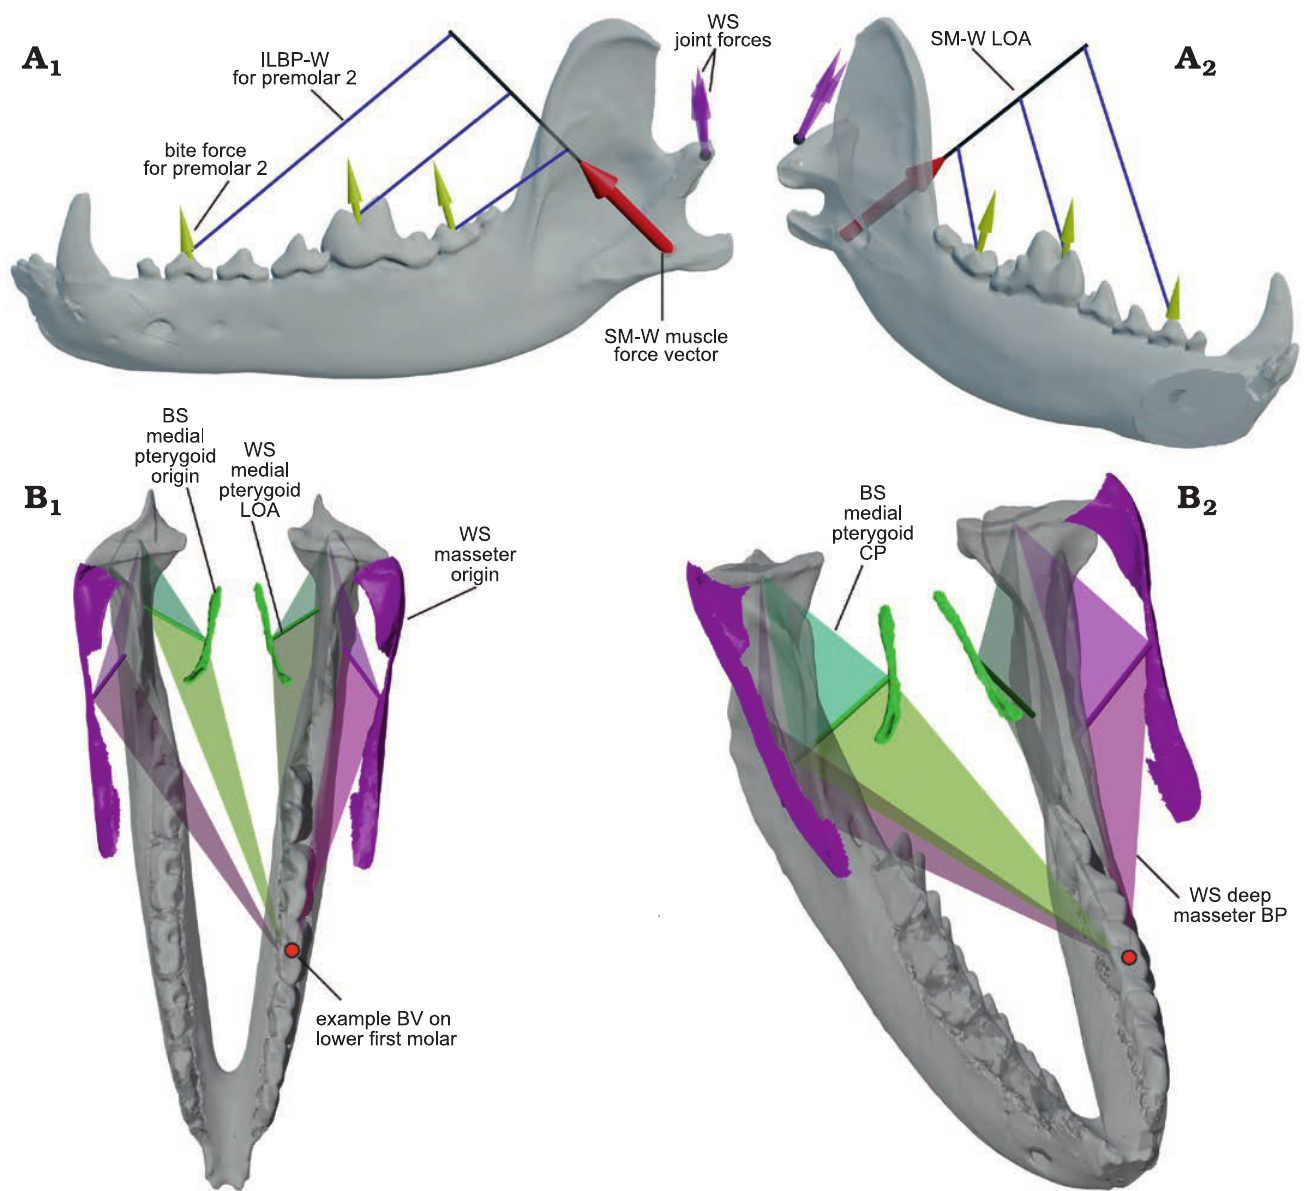
Fig. 4. Example 3D renderings of the bifulcral mandibular leverage parameters used in this analysis. A . Example of bifulcral lever arms corresponding to the working-side superficial masseter (SM-W) shown in a semi-transparent hemimandible of Canis familiaris Linnaeus, 1758; the muscular resultant vector is shown as a red arrow, with corresponding bite force vectors (yellow arrows) and working-side joint force vectors (purple arrows) shown for three positions on the lower postcanine tooth row. As can be seen, the in-lever lengths around the bite point fulcra (used in the calculation of joint force) increase significantly mesially. In labial (A 1 ) and oblique (A 2 ) views. B . Example of the varying condylar planes (CP) and bite planes (BP) used in the 3D bifulcral analysis, shown in Diceros bicornis (Linnaeus, 1758) for a bite point on the lower first molar. The mandible is shown in semi-transparent gray, while the working- and balancing-side origin surfaces for the deep masseter muscles on the skull are shown bilaterally in solid pink; similarly, the isolated origin surfaces of the medial pterygoids are shown in solid green. The muscular lines of action (LOA) for these four muscles are also shown as solid tubes, while transparent triangles demonstrate the orientations of the CP and BP for the corresponding muscle. In superior (B 1 ) and oblique (B 2 ) views. Not to scale. Abbreviations: BS, balancing-side; BV, bite vertex; ILBP-W, in-lever of the bite plane on the working-side; SM-W, superficial masseter working-side; WS,